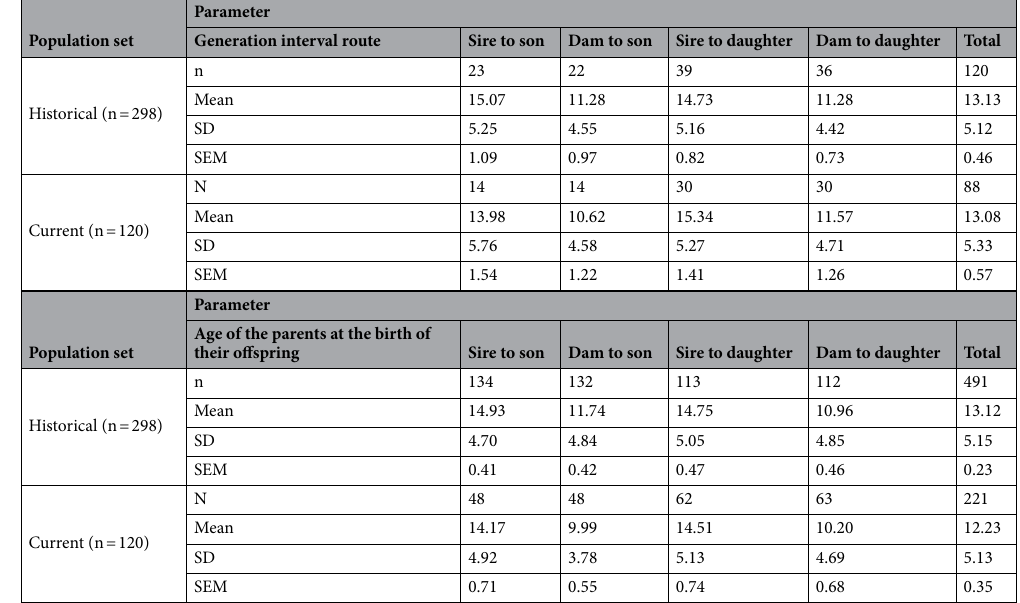
Table 2. Average generational intervals and mean age of the parents at the birth of their offspring (years) and dispersion statistics (Standard deviation, SD and Standard error of the mean, SEM) for population groups.